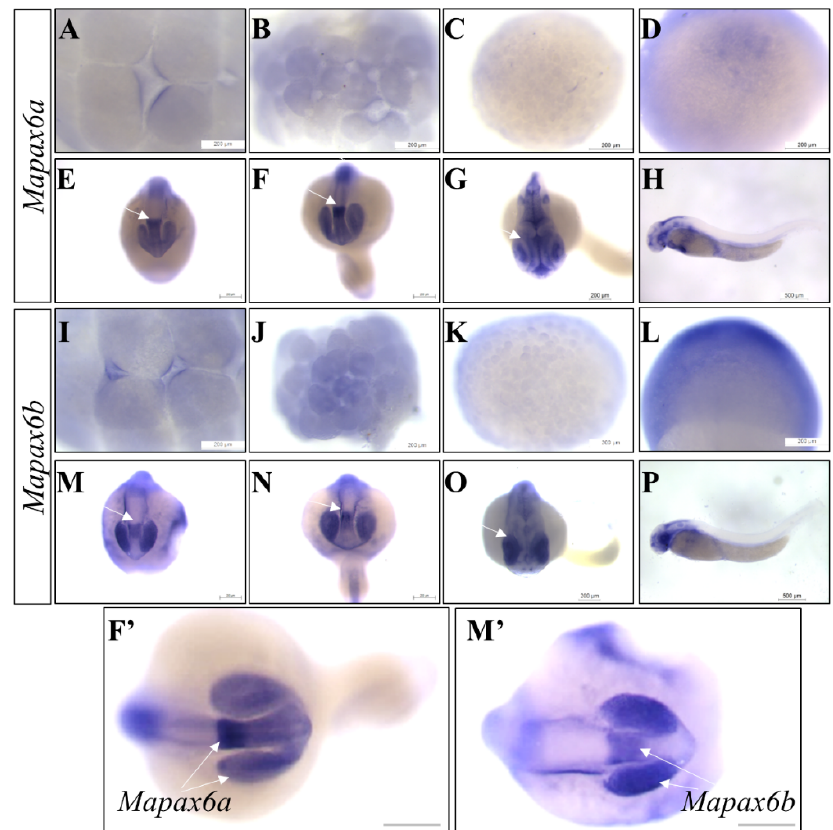
Figure 4. RNA expression of Mapax6a and Mapax6b during embryogenesis. Whole embryos at various stages were subjected to in situ hybridization (ISH) with antisense riboprobes of Mapax6a and Mapax6b and observed under microscopy. ( A–H ) The signals were stained with Mapax6a antisense probe; ( I–P ) the signals were marked by Mapax6b antisense probe. ( A , I ) 16-cell stage; ( B , J ) 32-cell stage; ( C , K ) blastula stage; ( D , L ) gastrula stage; ( E , M ) eye anlage stage; ( F , N ) caudal fin anlage stage; ( G , O ) heart-beat stage; ( H , P ) hatching; ( F’ , M’ ) amplification of Mapax6a or Mapax6b signal. Scale bars: 200 μ m.